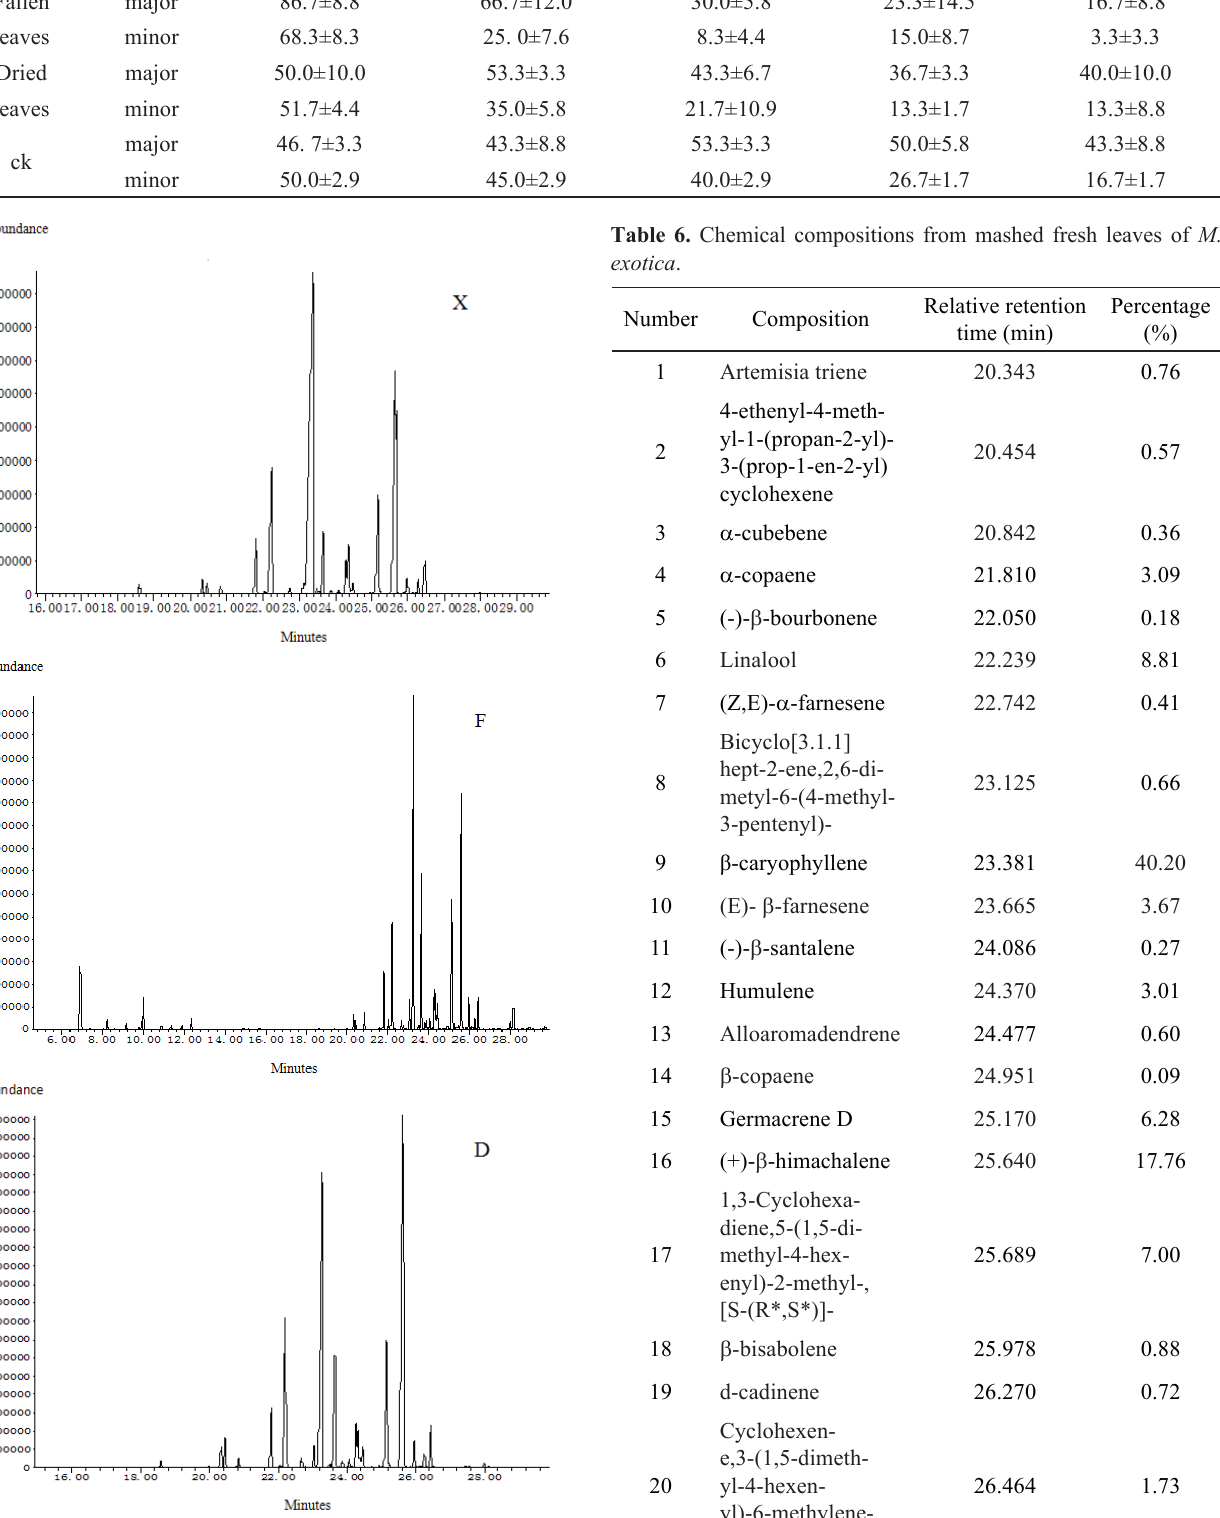
Fig. 5 GC-MS total ion chromatograms of mashed fresh(X), fallen(F), and dried(D) leaves of M. exotica .